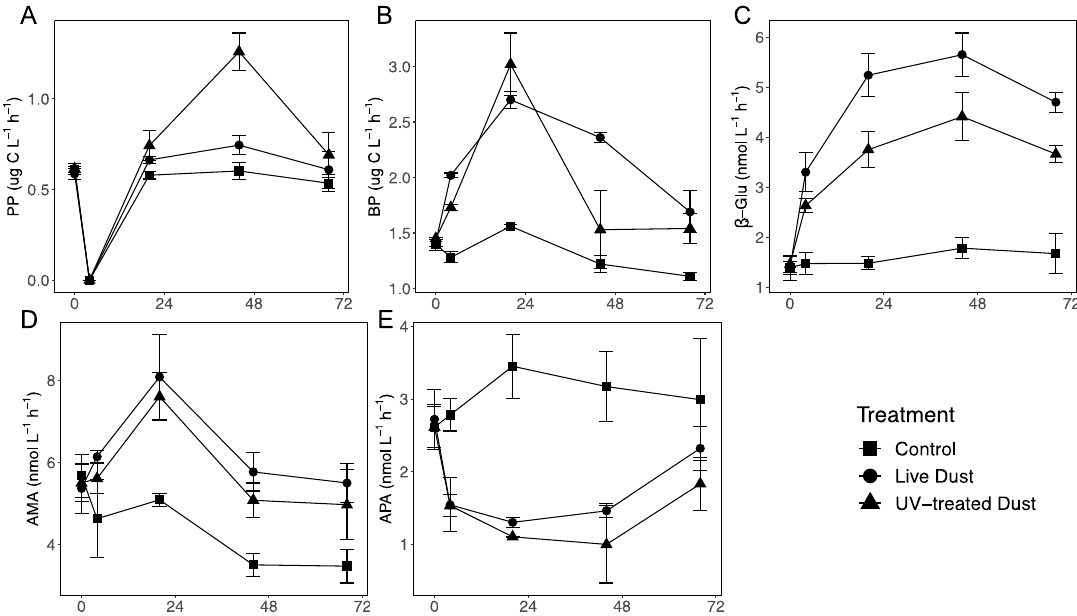
Figure 3. Temporal variability in primary production (PP) ( A ), bacterial production (BP) ( B ), beta-glucosidase ( β -Glu) ( C ), leu-aminopeptidase (AMA) ( D ), and alkaline phosphatase activity (APA) ( E ) following 0.8 mg L − 1 of “live dust” (circle), “UV-treated dust” (triangle) or unamended controls (square). Data shown are the average ± SD ( n = 3).